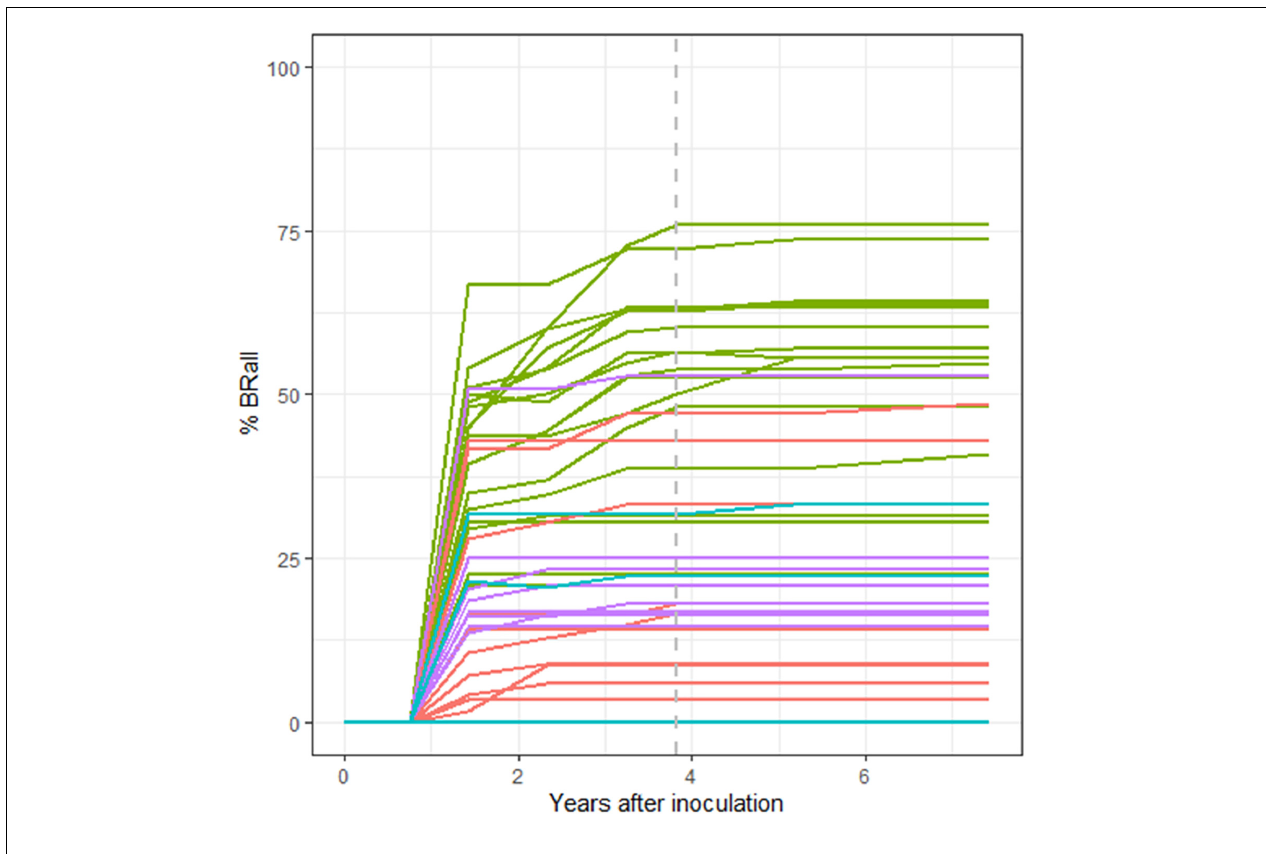
FIGURE 7 | Temporal trend in family percent complete bark reactions and partial bark reactions (%BR all ). Lincoln R (green), Lincoln S (blue), Cibola (pink) and Santa Fe (purple) %BR all continued to rise throughout the trial with families reaching a maximum mean %BR all near 5th assessment (3.83 years post-inoculation: gray dashed line), although most bark reactions were noted less than 2 years